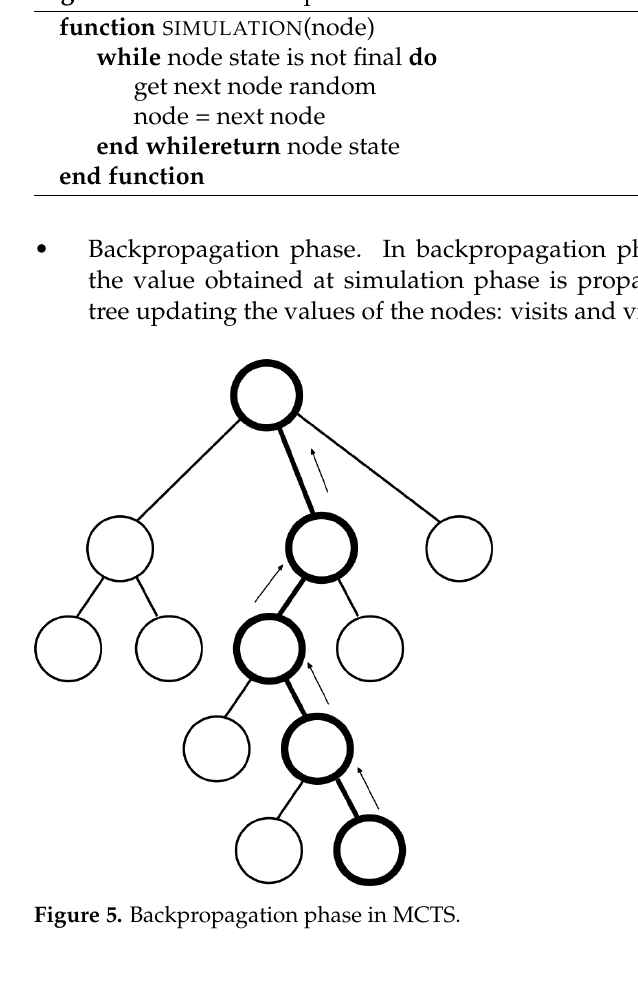
Figure 4. Simulation phase in MCTS. Algorithm 3 Simulation phase